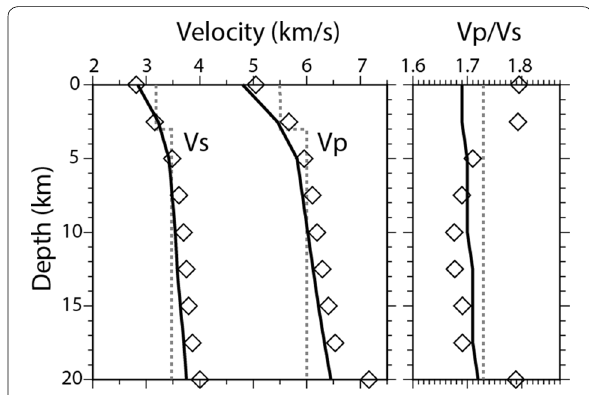
Fig. 3 Initial and final velocity models in this study. Solid lines initial = 1-D models used for the tomography, based on JMA2001 (Ueno et al. 2002). Dotted lines tentative 1-D models used to determine the = initial hypocenter locations. Diamonds mean velocity in each depth = layer that was acquired by the tomographic